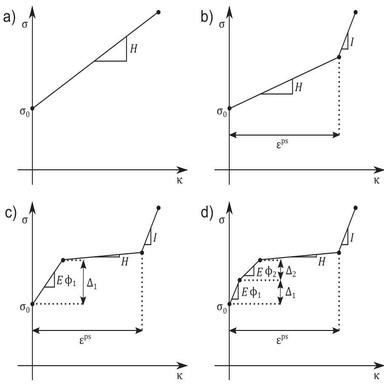
Stress-plastic work curve of the multilinear models (a) MISO2, (b) MISO3, (c) MISO4 and (d) MISO5.